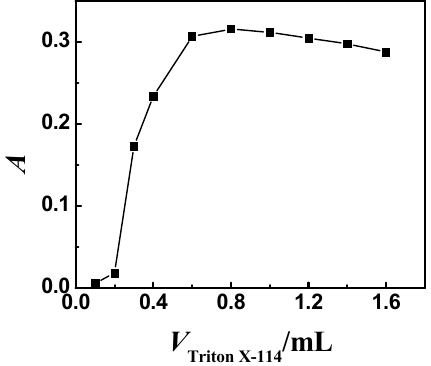
Figure 3. Effect of the amount of Triton X-114 on absorbance (peak area). Thirty nanograms Ni, 0.25 mL 5 × 10 − 4 mol L − 1 5-Br-PADMA; 1.0 mL 0.5% SLS; temperature: 60 °C; heating time: 10 min; 3.5 ng mL − 1 ; pH = 5.0.